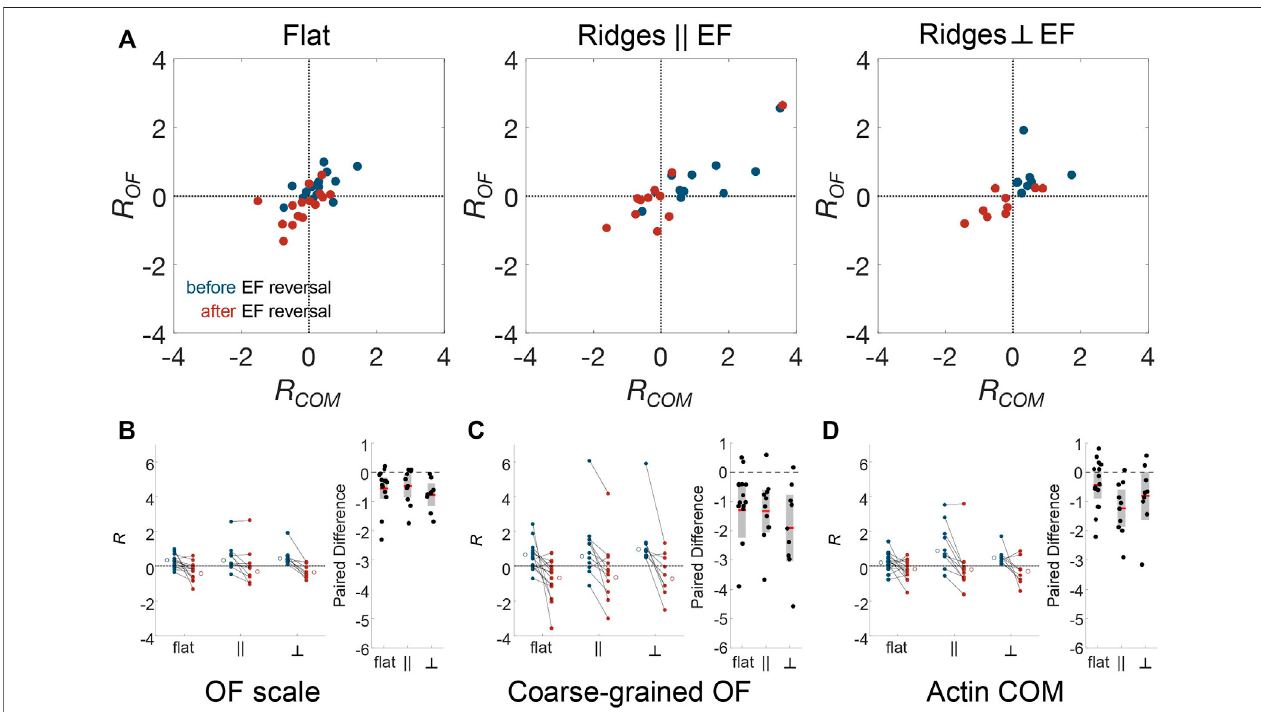
FIGURE 5 | Actin dynamics on multiple scales is correlated, and responds to changing EF direction, independent of nanotopographic guidance. To compare EF guidanceofactin wavesand,therefore, thecellpolarity acrosssubstratetype andanalysismethod, theangulardistributions weresplitbyangle,and thelogarithmofthe ratio of leftward angle counts to rightward angle counts ( R ) was calculated. Positive R indicates fl ow towards the left and negative R indicates fl ow towards the right. (A) Comparison between the small-scale optical- fl ow measurement ( Figures 4A,B ) and the whole-cell, actin-center-of-mass measurement ( Figures 4E,F ) before (blue) and after (red) EF reversal. Combined results of cell-scale polarity before and after EF reversal at (B) optical- fl ow scale, (C) the coarse-grained OF scale, (D) the cellular scale, and their paired differences, respectively.